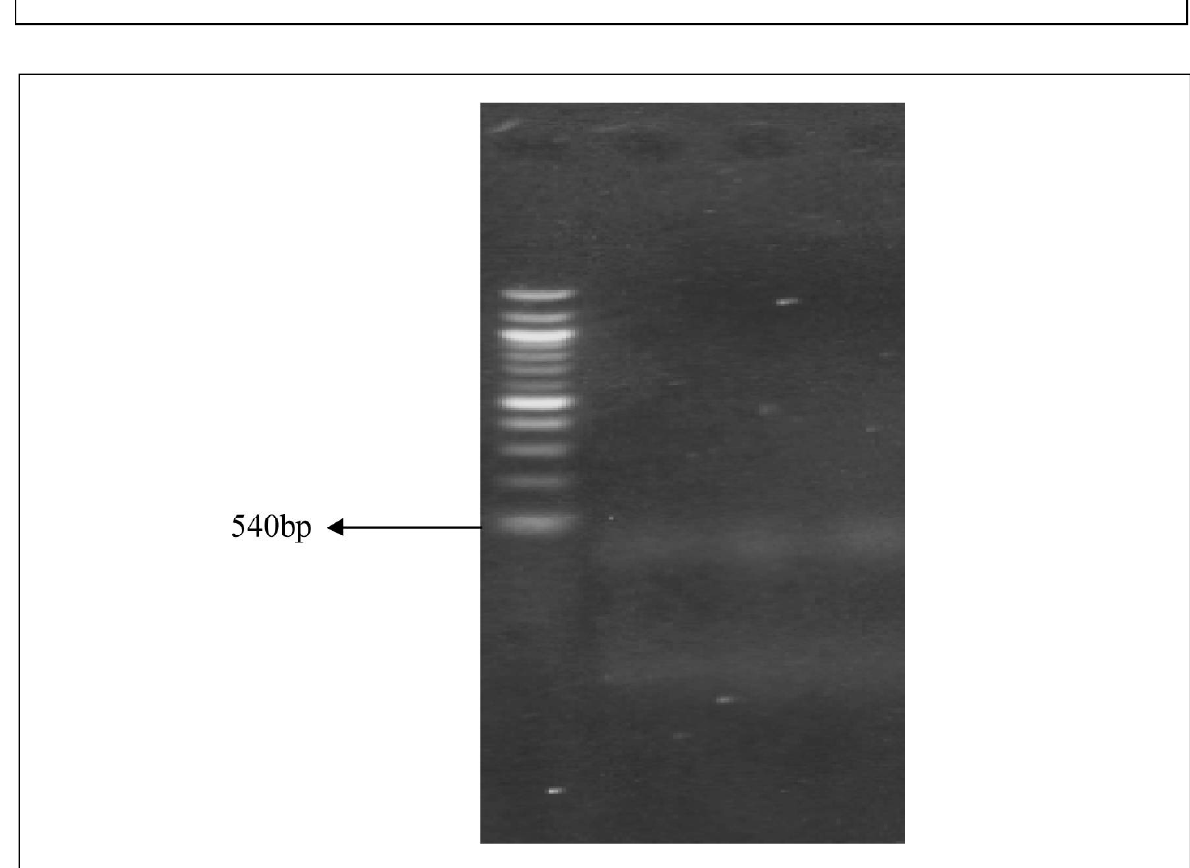
Figure 3: Isolates possessing catA1 gene confirming resistance to